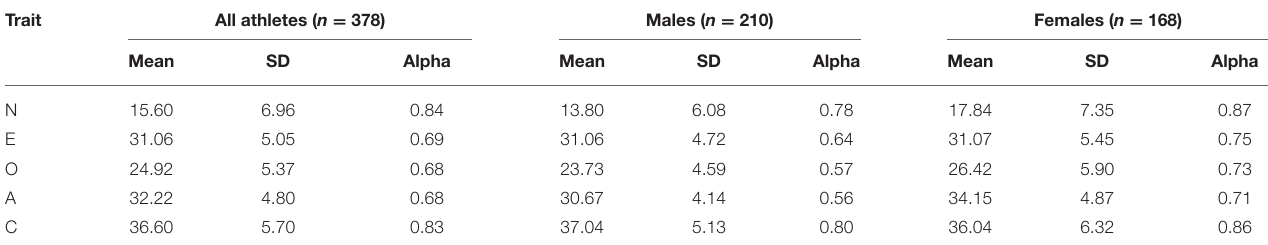
TABLE 2 | Descriptive NEO-FFI statistics ( n = 378, plus gender separation, raw scores). Trait